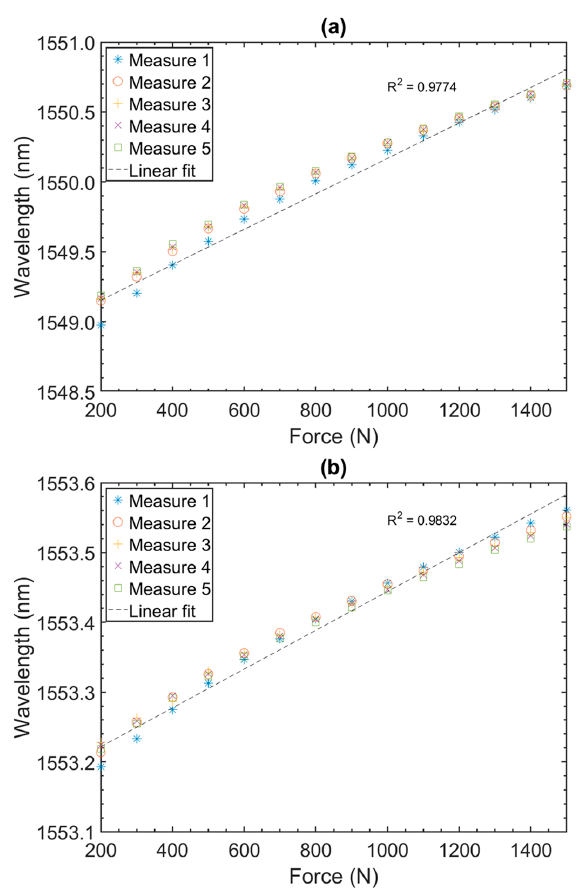
Figure 7. Static test results performed on PEEK ( a ) and TB ( b ) sensors for force values below 2000 N.